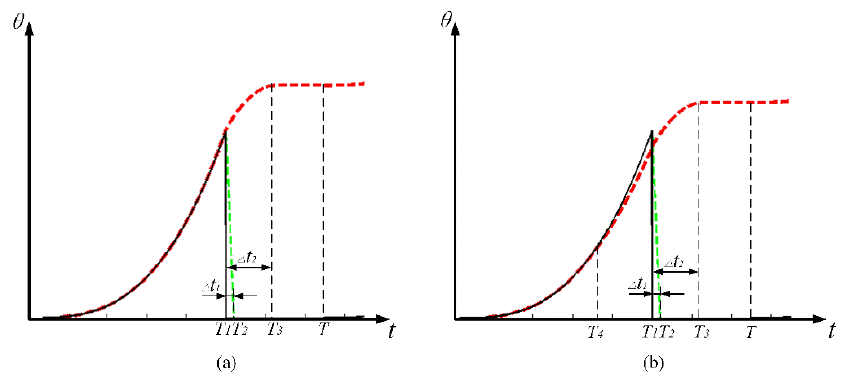
Figure 6. The driving pulse (solid line) and the rotor response (the red dotted line) with specific time sections in two motion models: ( a ) stick – shoot model; ( b ) stick – slip-shoot model.